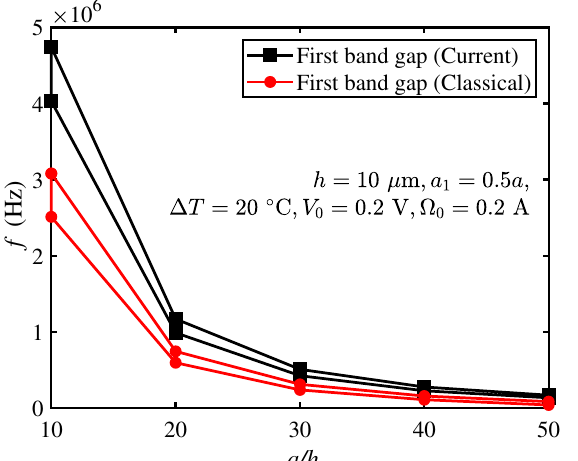
Figure 5. Bandgaps of the current and classical models varying with the normalized lattice constant a / h